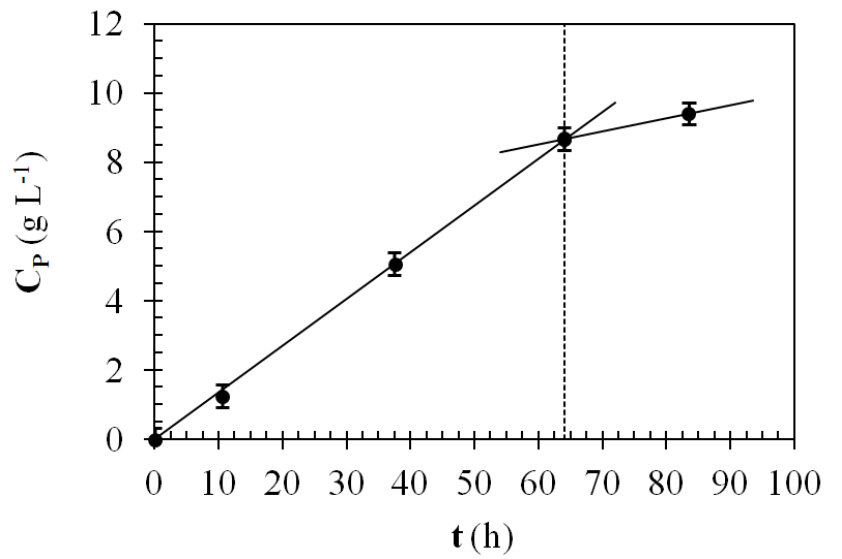
Figure 3. Oxidation of D -sorbitol to L -sorbose with G. oxydans ink-jet printed 30 × 30 dot arrays, three drops per dot, one-to-two diluted ink, in 0.5 mL SP buffer at 30 °C and 90 rpm: concentration of L -sorbose ( C ) as a function of time ( t ). After 64 h of incubation, P the ink-jet printed polyester patches were removed from the 24-well plate. Data refer to the mean and standard deviation of three replicated